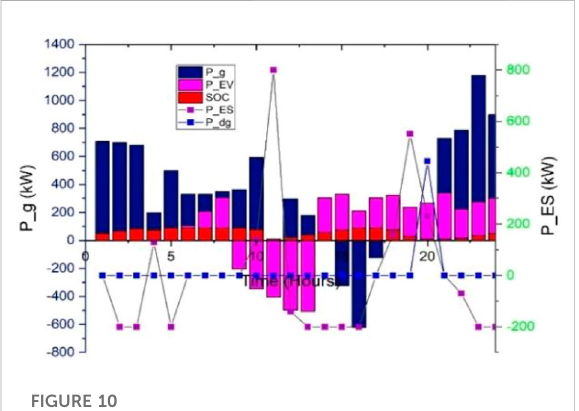
FIGURE 10 Grid with EV and all components.